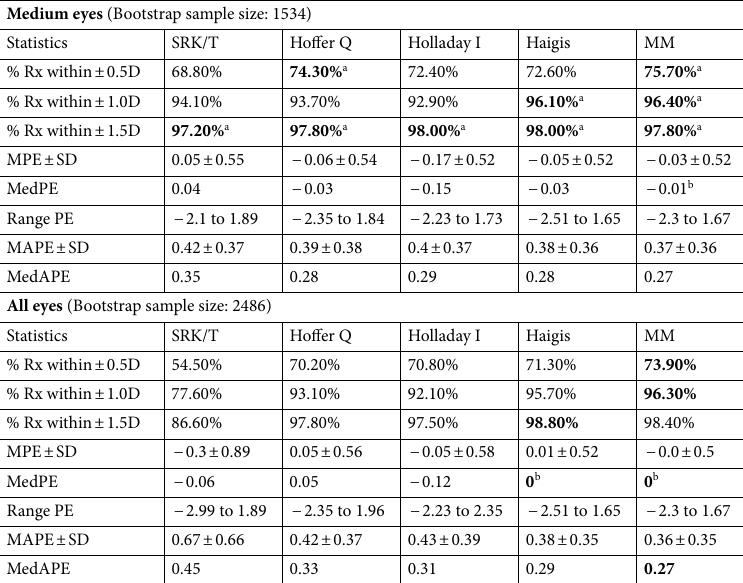
Table 3. Summary statistics of the cross-validation results for each of the five formulae (SRK/T, Hoffer Q, Holladay I, Haigis and MM) for medium and all eyes. % Rx Percentage of eyes within a given range of prediction error, MPE Mean prediction error, MedPE Median prediction error, Range PE Range of the prediction error, MAPE Mean absolute prediction error, MedAPE Median absolute prediction error, SD Standard Deviation of the error. a No statistically significant difference at level 0.05. b No statistically significant difference from zero at level 0.05. Significant values are in